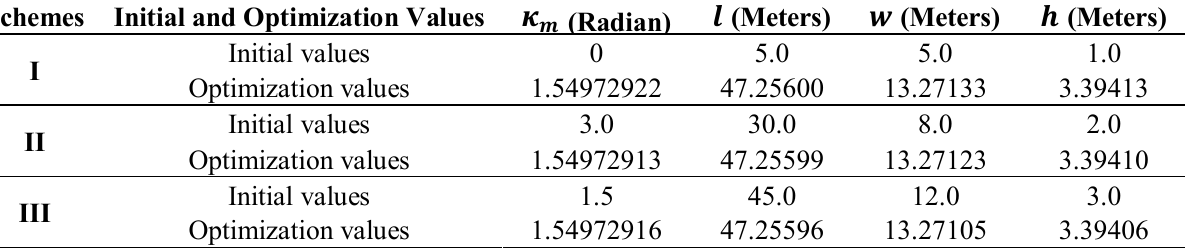
Table 2. Comparison of optimization results using the different initial model